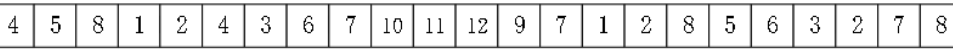
Figure 9. Chromosomal form.